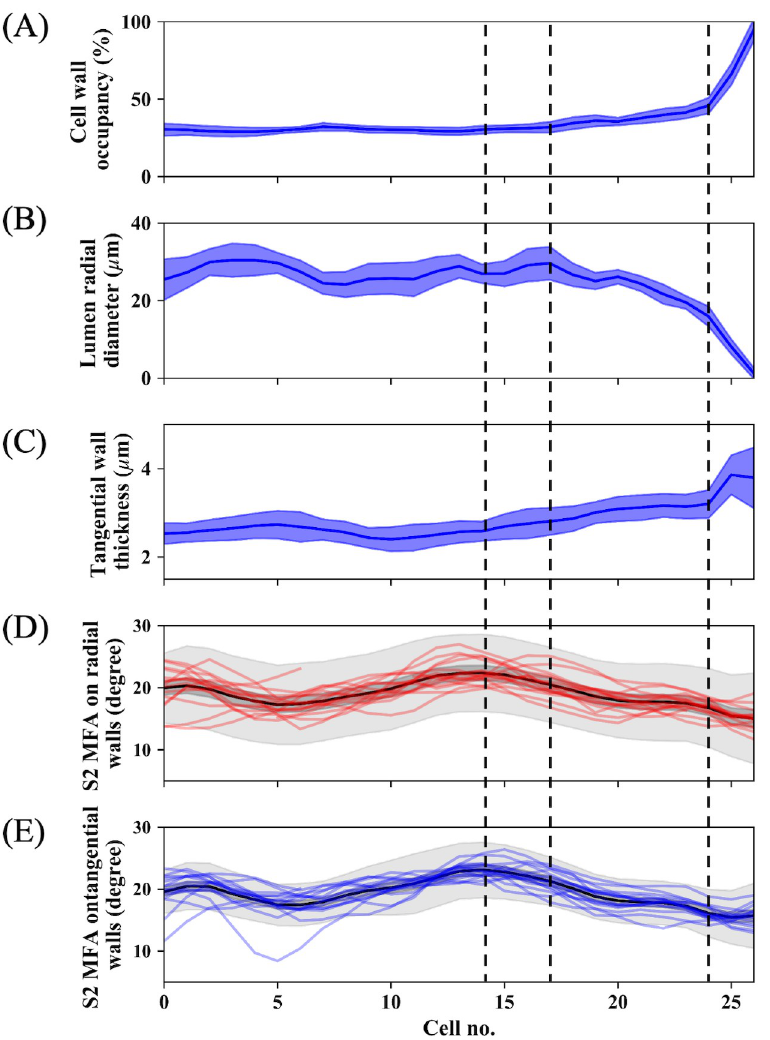
Fig 7. Comparison of normalized intra-annual transitional behaviors of anatomical parameters and S 2 microfibril angle (MFA). (A) Cell wall occupancy, (B) lumen radial diameter, (C) tangential wall thickness, (D) S 2 MFA on radial walls, and (E) S 2 MFA on tangential walls. In (A–C), blue solid lines and the shaded area surrounding them indicate the mean intra-annual transitions and their standard deviation, respectively. In (D) and (E), black solid lines, and gray and dark gray bands correspond to the mean intra-annual trends of S 2 MFA, their standard deviations, and standard errors of the mean, respectively. Red and blue lines in (D) and (E) indicate normalized S 2 MFA transitions of each radial file in the radial and tangential walls, respectively. Horizontal dotted lines indicate the positions of Cell no. 15, 18, and 25 from the left side, respectively. Cell no. 1 corresponds to the tracheid positioned at the most earlywood. Cell number ranges from no. 1 to no. 27 in normalized radial